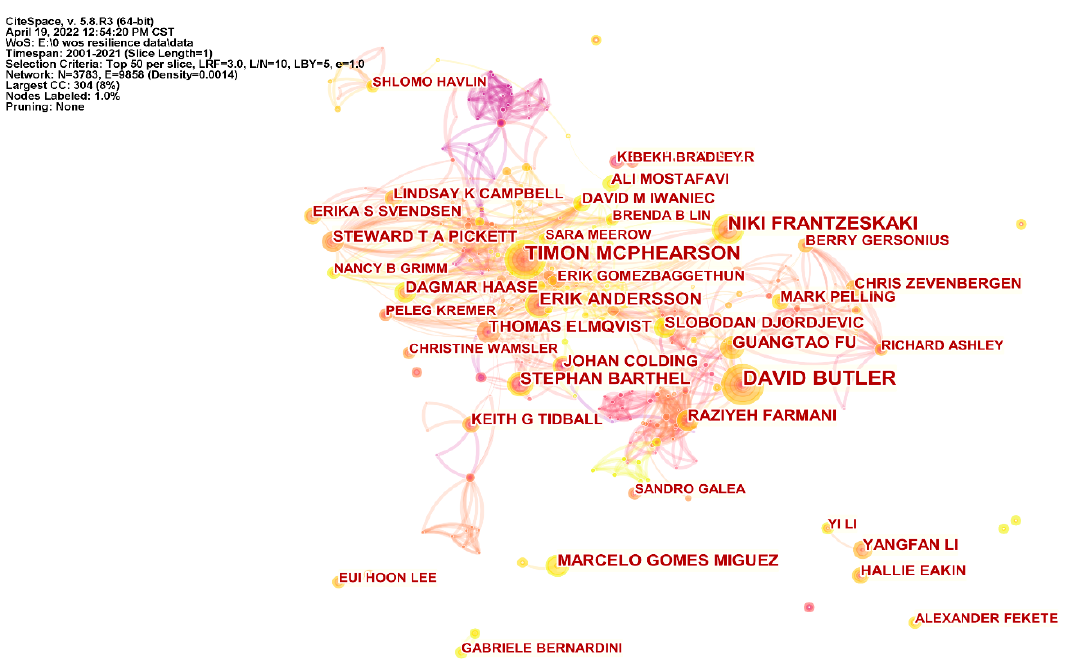
Figure 3. Collaborative co-occurrence map of RC authors.